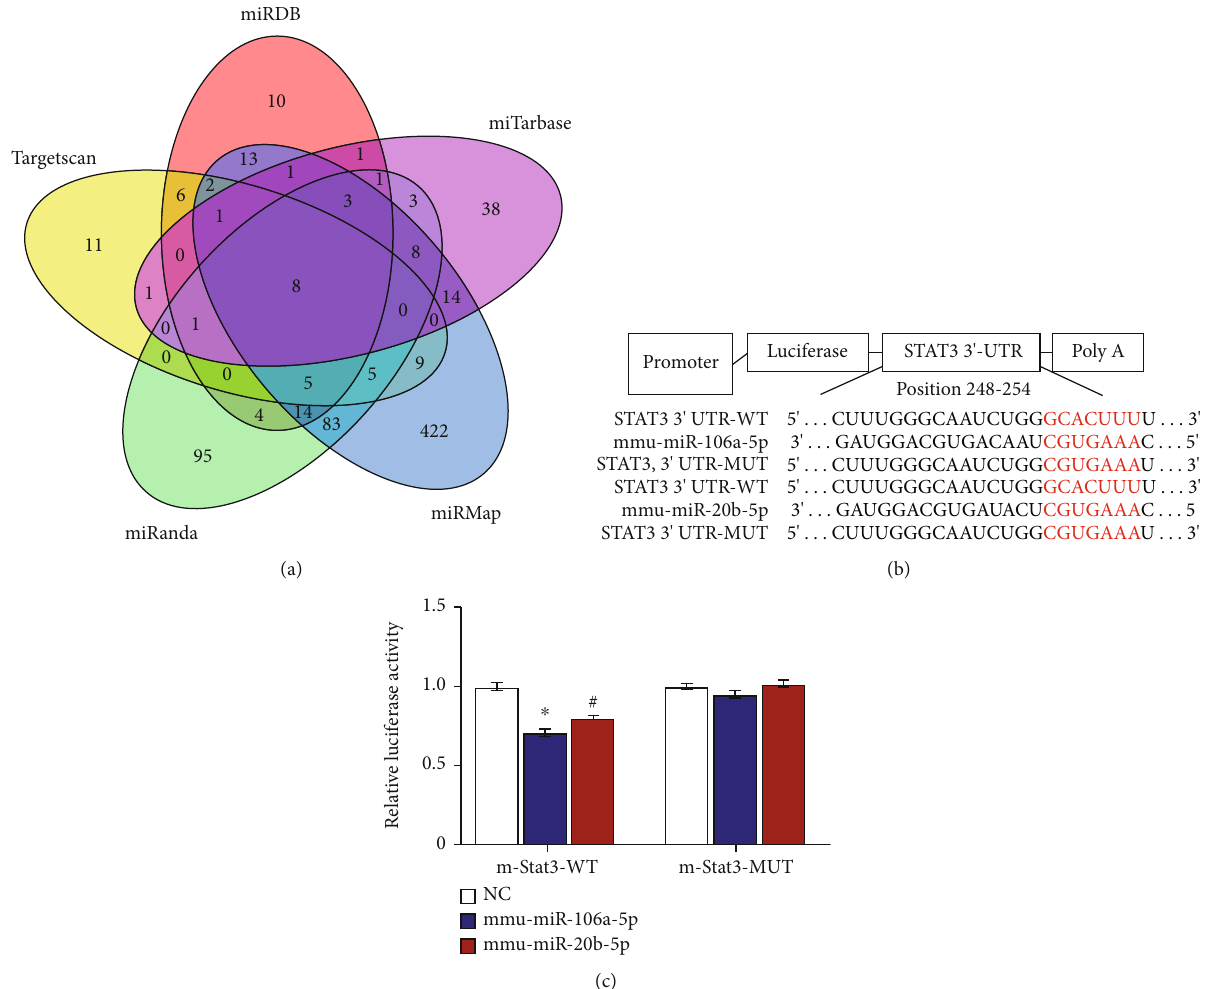
Figure 6: Identi fi cation of miR-106a/20b, which regulates STAT3 expressions. (a) The predicted consequential pairing between the miRNA (miR-106a and miR-20b) and STAT3 3 ’ -UTR; (b and c) Relative luciferase activity upon cotransfection of the empty reporter (vehicle) with pmiR-RB-STAT3-WT or pmiR-RB-STAT3-MUT and the control miRNA, miR-106a, or miR-20b mimic. ∗∗∗ p < 0 : 001 . Table 2: Distribution and association of the miRNA with